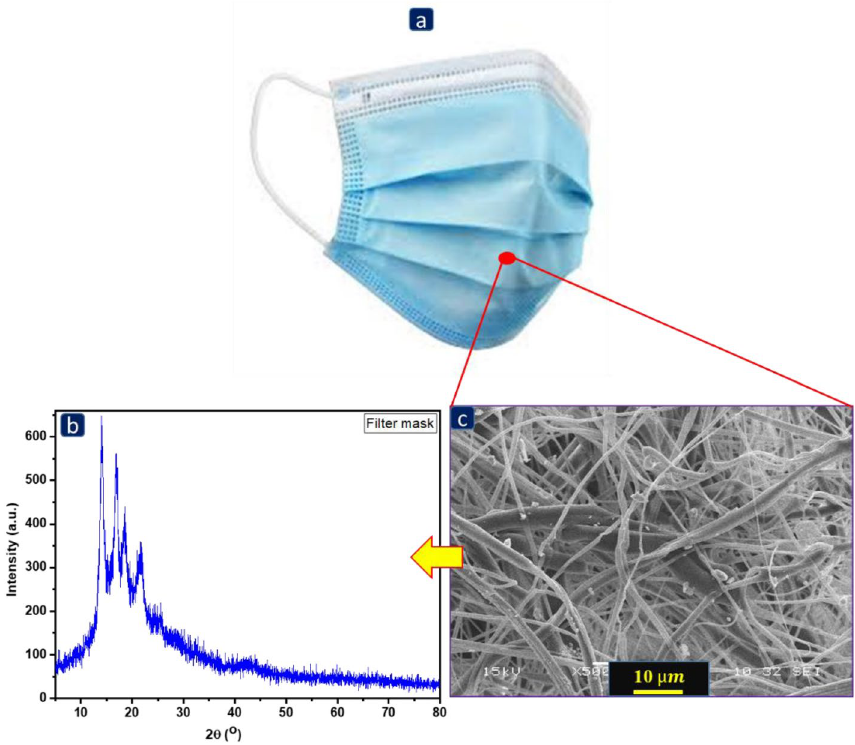
Figure 2. ( a ) Image of single-use facemask, ( b ) XRD image of FM fibers, and ( c ) appearance of facemask layers under scanning electron microscopy at 1000× .